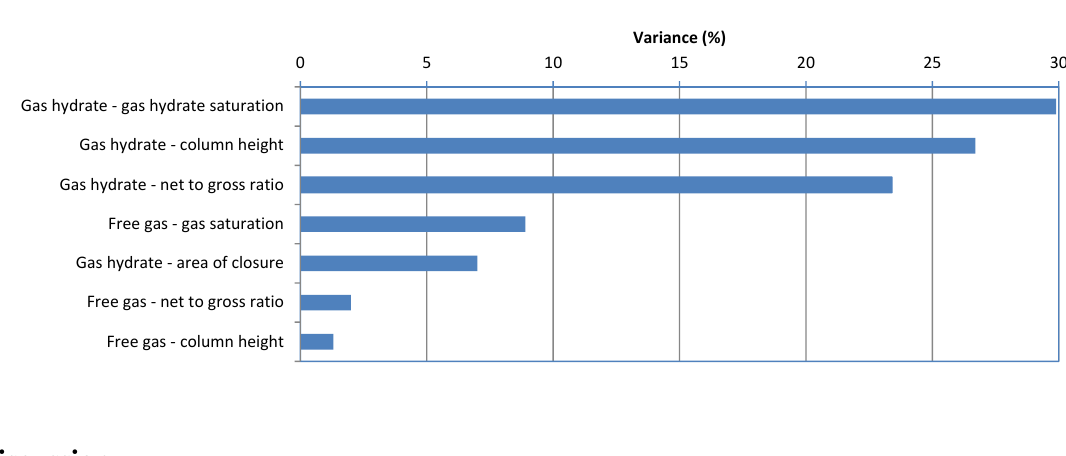
Figure 11. A variance diagram showing the relative importance of the various reservoir parameters on the result. Note the dominance of the uncertainty related to the gas hydrate zone, particularly gas hydrate saturation, the column height of the gas hydrate zone and the net to gross